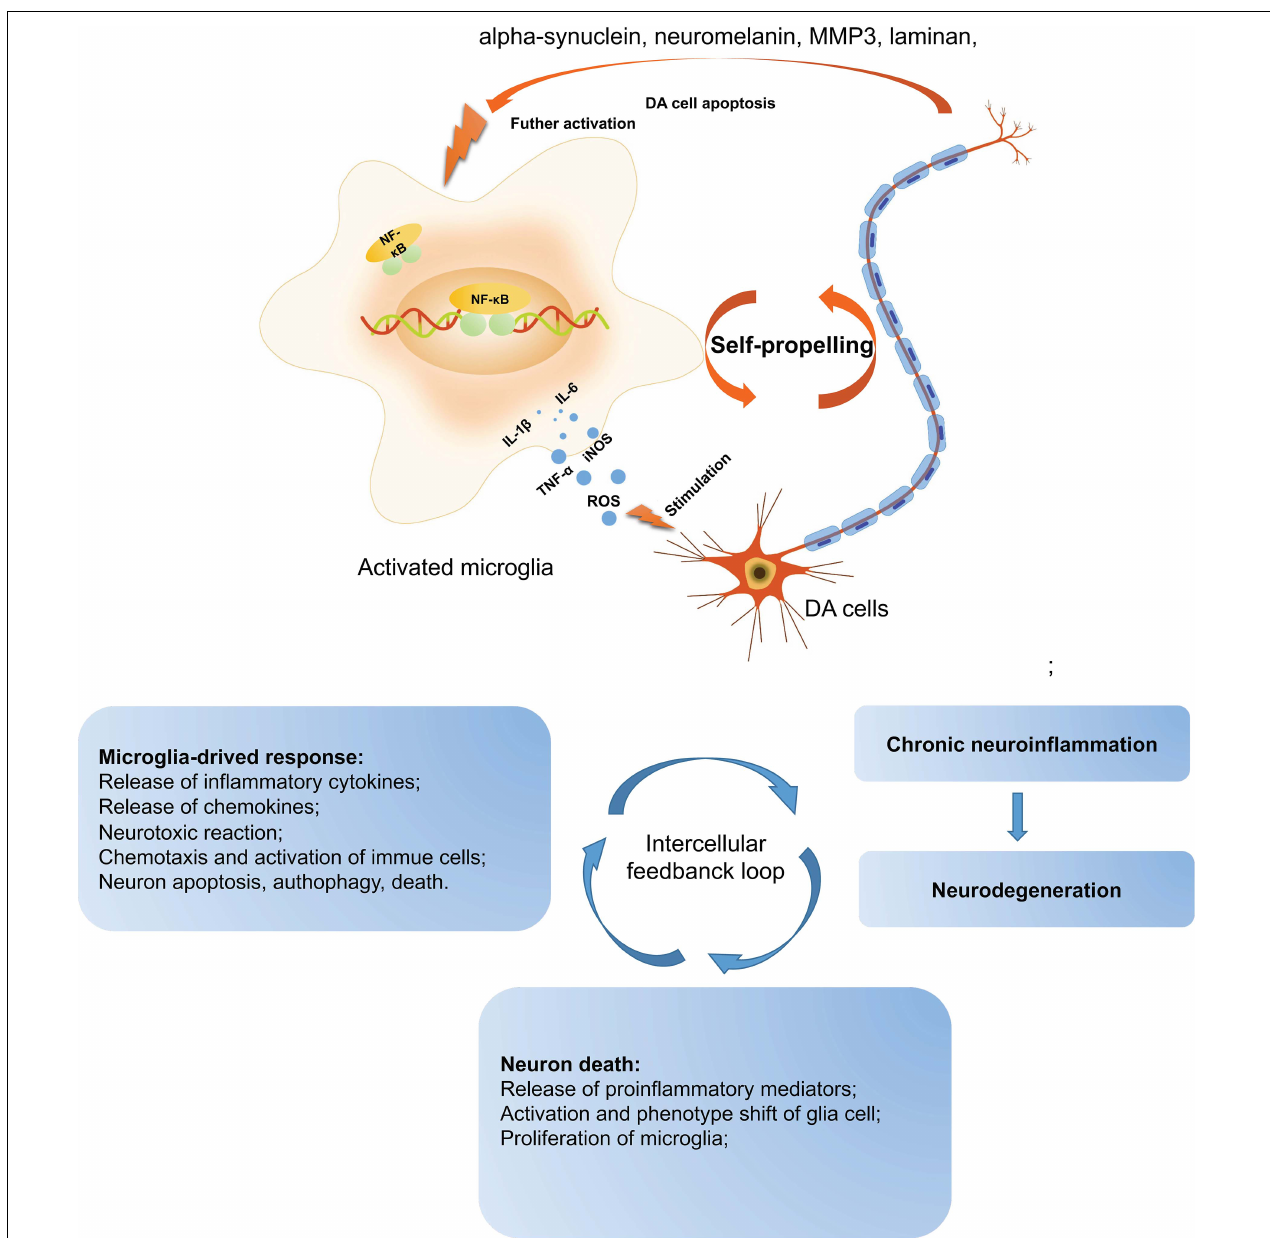
FIGURE 1 | A self-propelled degeneration cycle in PD. In PD’s pathological conditions, microglia are activated and release anti-inflammatory cytokines to repair the tissues, protecting neurons against apoptosis or death. However, the continuous stimulation of pathological factors increases the number of toxic phenotypes of microglia, releasing a large number of inflammatory cytokines, such as TNF- α , IL-1 β , iNOS, IL-6, and ROS, which contribute to neuronal damage. Besides, the impaired or dead DA neurons can directly induce microglial activation, increasing ROS and pro-inflammatory cytokines. Thus, the activation of microglia and DA neuronal damage form a self-propelled degeneration cycle in PD. PD, Parkinson’s disease; DA, dopaminergic; ROS, reactive oxygen species; iNOS, inducible nitric oxide synthase; IL-6, interleukin-6; TNF- α , tumor necrosis factor- α ; IL-1 β , interleukin-1 β